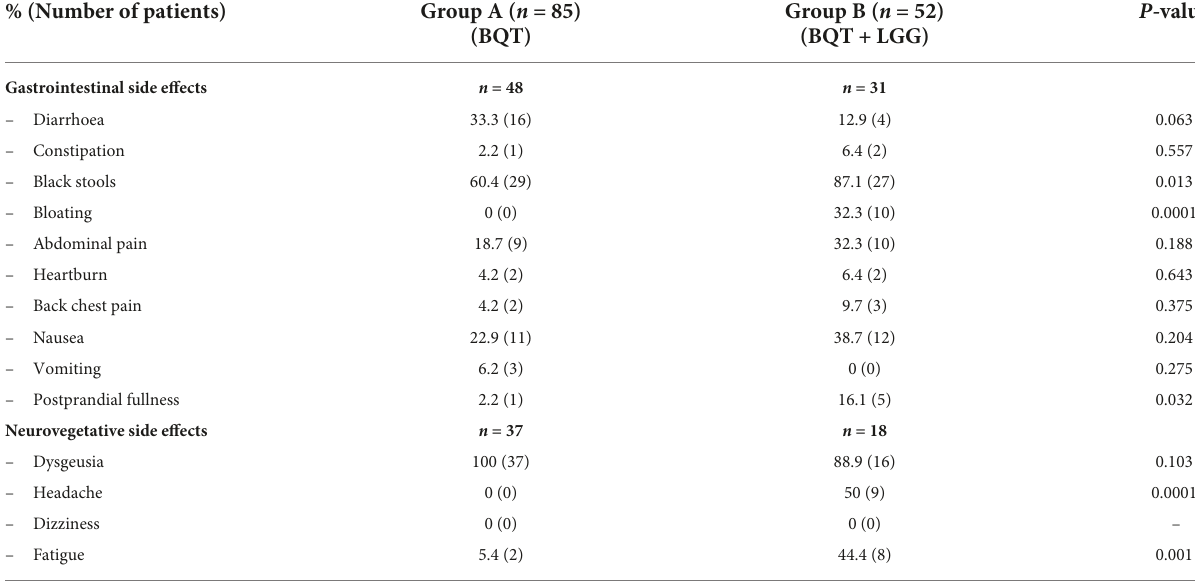
TABLE 2 Side effects encountered during the 10 days of three-in-one bismuth-quadruple therapy (BQT) eradication therapy. % (Number of